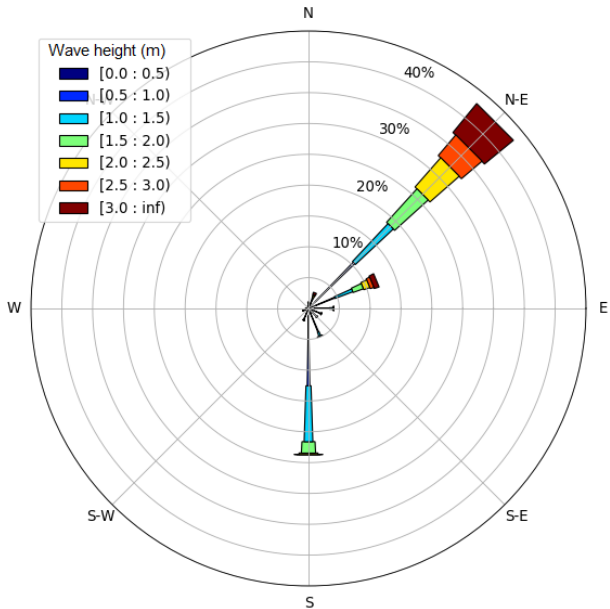
Fig. 2. Long-term wave rose from WAVEWATCH data at sampling location 110°E, 13.5°N